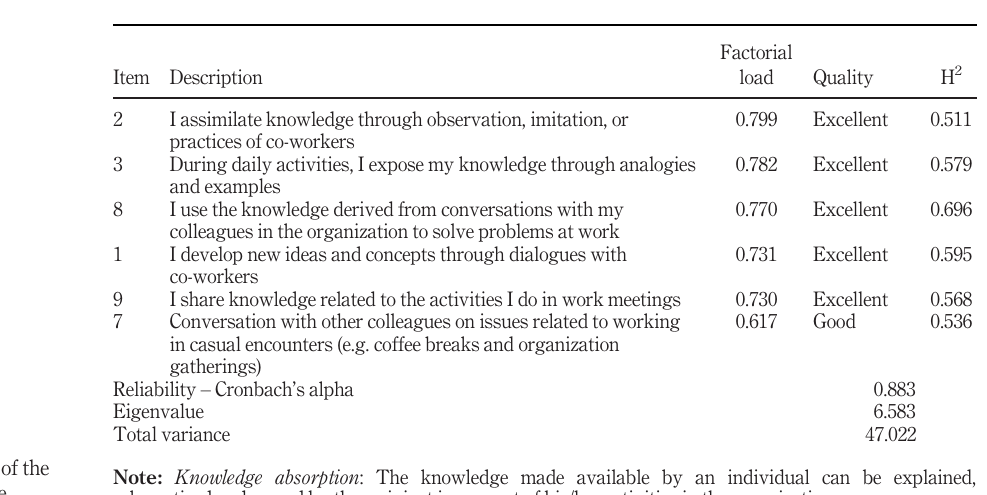
Table V. Synthesis of the knowledge absorption